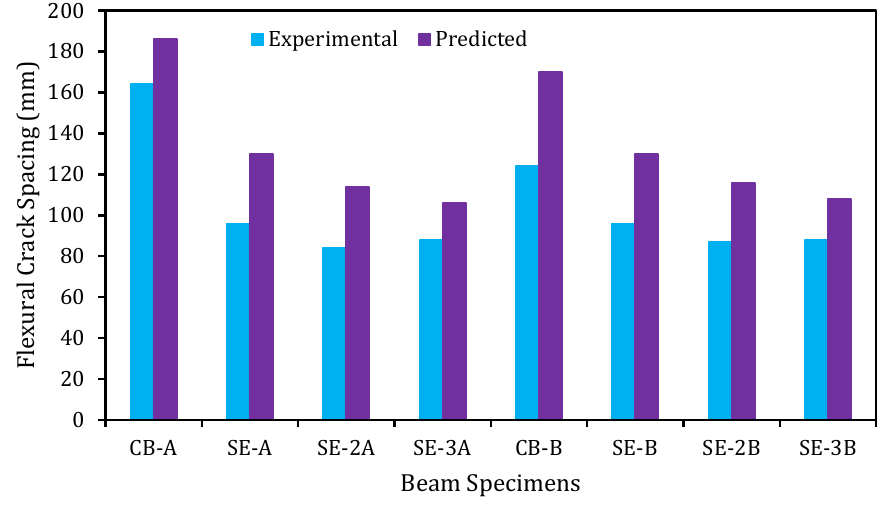
Figure 15. Experimental and predicted crack spacing.